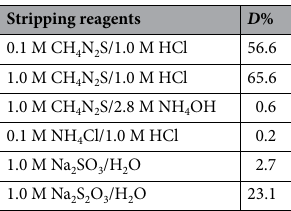
Table 1. Pd(II) desorption percentage ( D %) using stripping reagents combined with acids or bases.